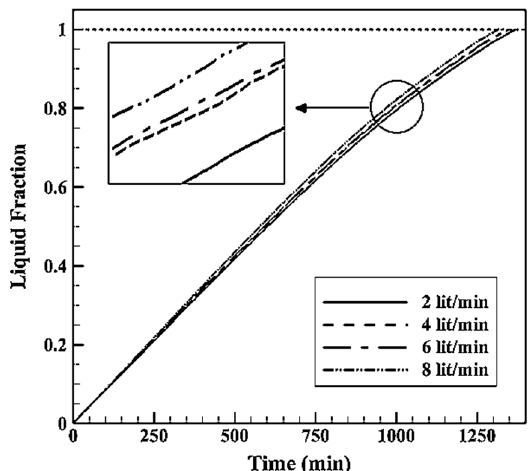
Figure 10. Temporal evolution of the liquid fraction for different inlet flowrates of ethylene glycol.